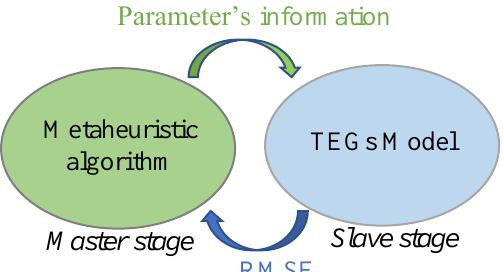
Figure 1. Proposed methodology for parameters identification in